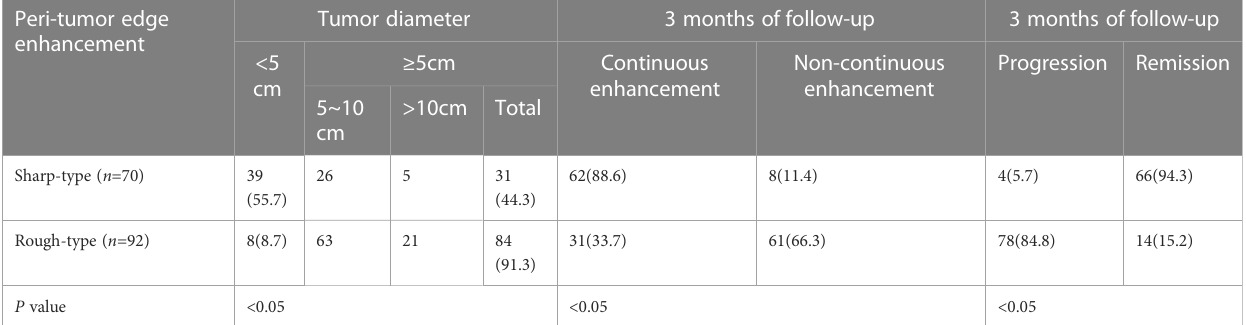
TABLE 4 Comparison of indexes between two types of the peri-tumor edge enhancement by contrast-enhanced MRI in HCC patients after DEB- TACE (%). Peri-tumor edge Tumor enhancement